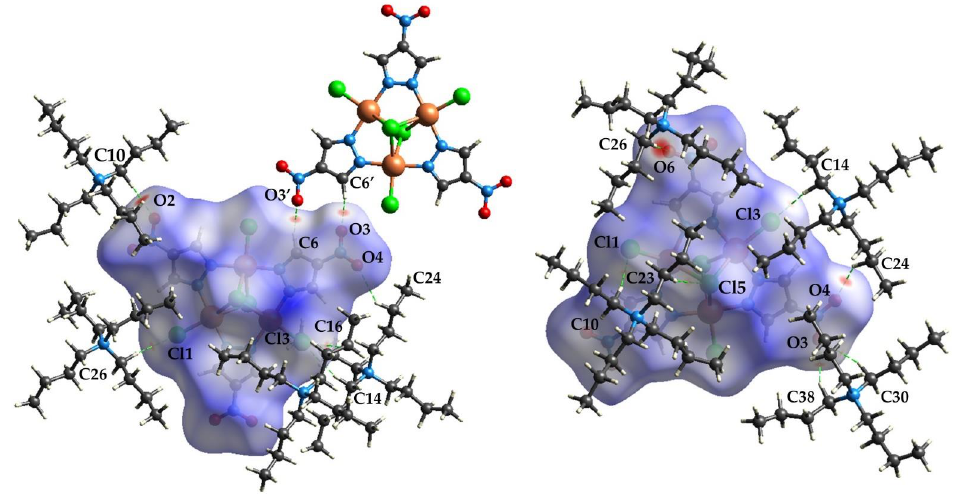
Figure 6. Hirshfeld surface of the front ( left ) and back ( right ) of the [Cu 3 (μ 3 -Cl) 2 (μ -4-NO 2 -pz) 3 Cl 3 ] 2- unit of 1b showing the intermolecular interactions with the tetrabutylammonium cations and other Cu 3 dianionic complexes.